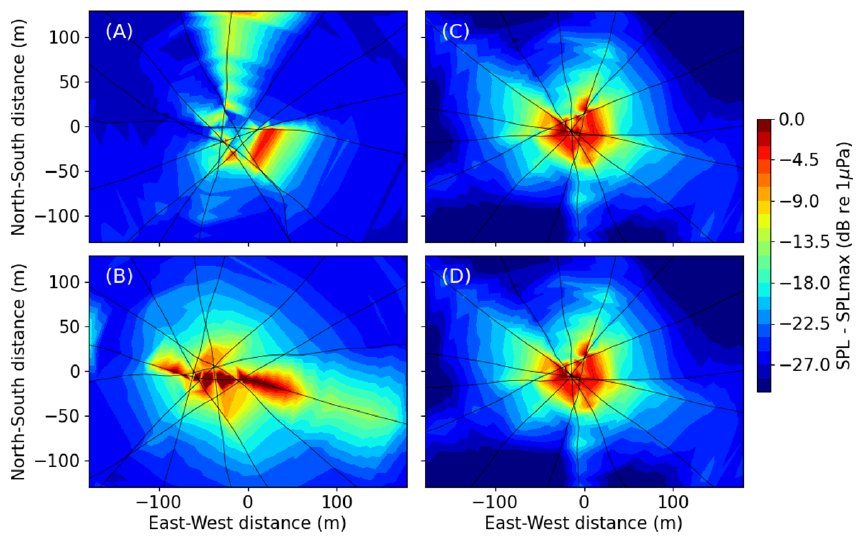
Figure 10. Received sound pressure levels (SPLs) in the 15–100 kHz range for the 200 kHz signal (198–206 kHz) at depths of ( A ) 5 and ( B ) 30 m and for the 83 kHz signal (80–87 kHz) at depths of ( C ) 5 and ( D ) 30 m in the shallow water. The maximum SPL (maxSPL) for the 200 kHz signal was 114.7 dB re 1 µPa m, and that for 83 kHz was 128 dB re 1 µPa m.